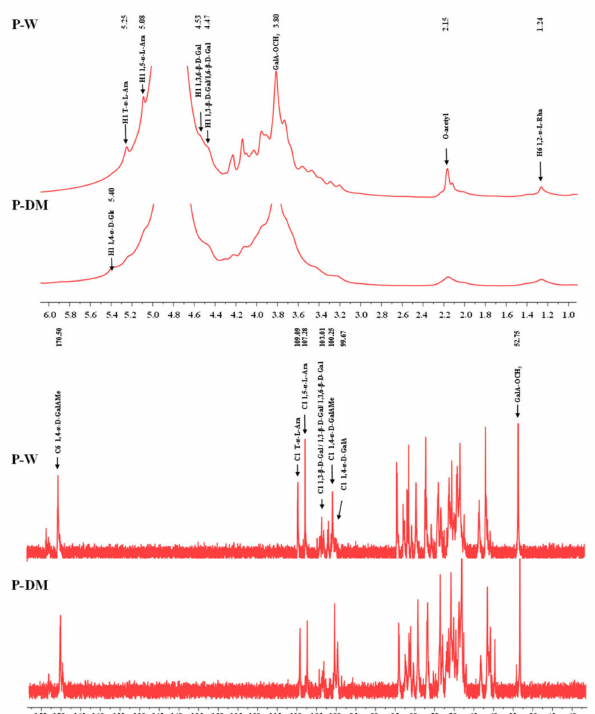
Figure 5. 1 H NMR and 13 C NMR spectra of polysaccharides extracted from sweet tea leaves. P- DM and P-W indicate polysaccharides extracted from sweet tea leaves by microwave-assisted deep eutectic solvent extraction and hot water extraction,